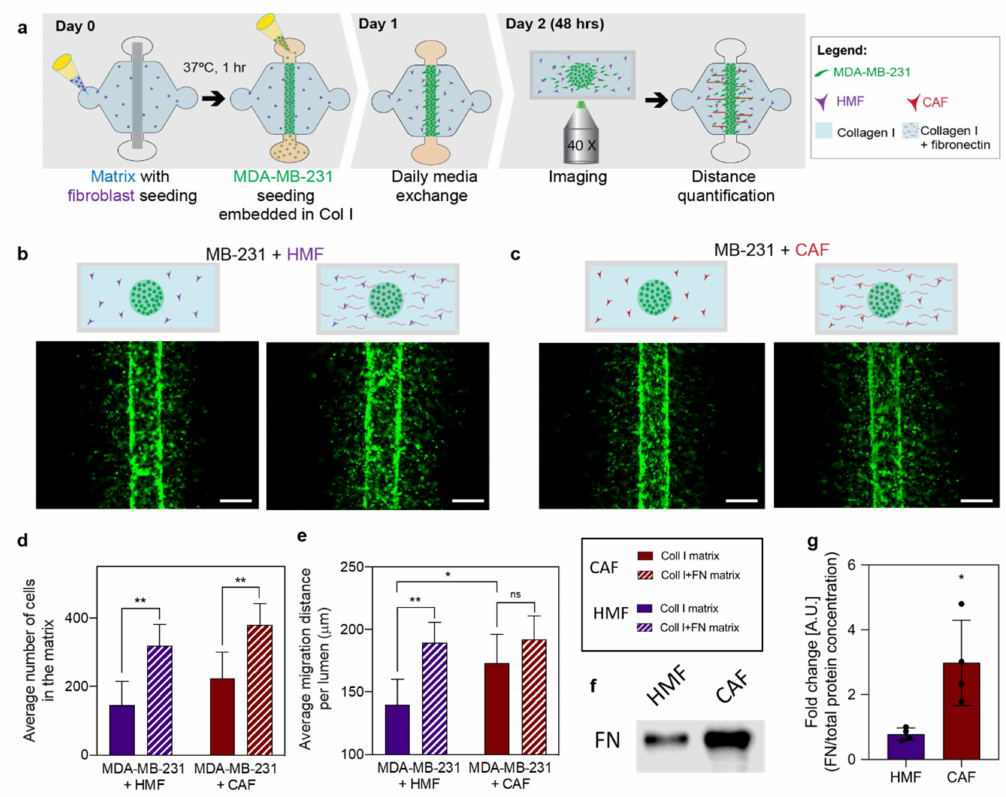
Figure 2. Influence of extracellular matrix (ECM) protein and fibroblast composition in cancer cell migration. ( a ) Schematic of the experimental process consisting of cell seeding, media exchanges, and imaging after 48 h of culture to track cell migration. ( b , c ) Fluorescence images of green fluorescent protein (GFP) tagged MDA-MB-231s within di ff erent matrix compositions in co-culture with human mammary (HMFs) and cancer-associated fibroblasts (CAFs). ( b ) MDA-MB-231 co-cultures with HMFs in a collagen matrix (left) and a fibronectin-rich matrix (right). ( c ) MDA-MB-231 co-cultures with HMFs in a collagen matrix (left) and a fibronectin-rich matrix (right). Scale bar = 200 µ m. ( d ) The average number of cells in the matrix. ( e ) Average migration distance measured from the edge of the lumen after 48 h of culture. ( f ) Representative western blot of fibronectin ( g ) Quantification of fibronectin protein normalized to total protein determined by SYPRO Ruby staining (whole lane fluorescence). Bars represent average ± SD, n = at least four individual devices. * p ≤ 0.05, ** p ≤